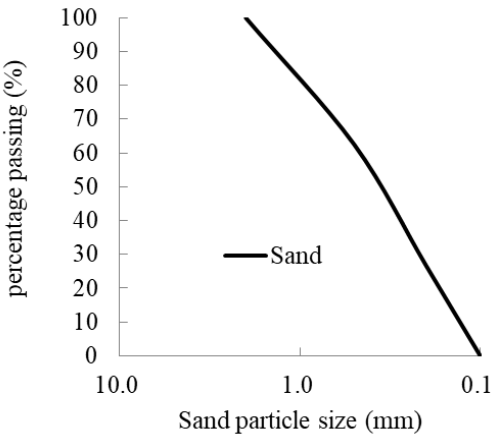
Figure 4. Particle size distribution curve.